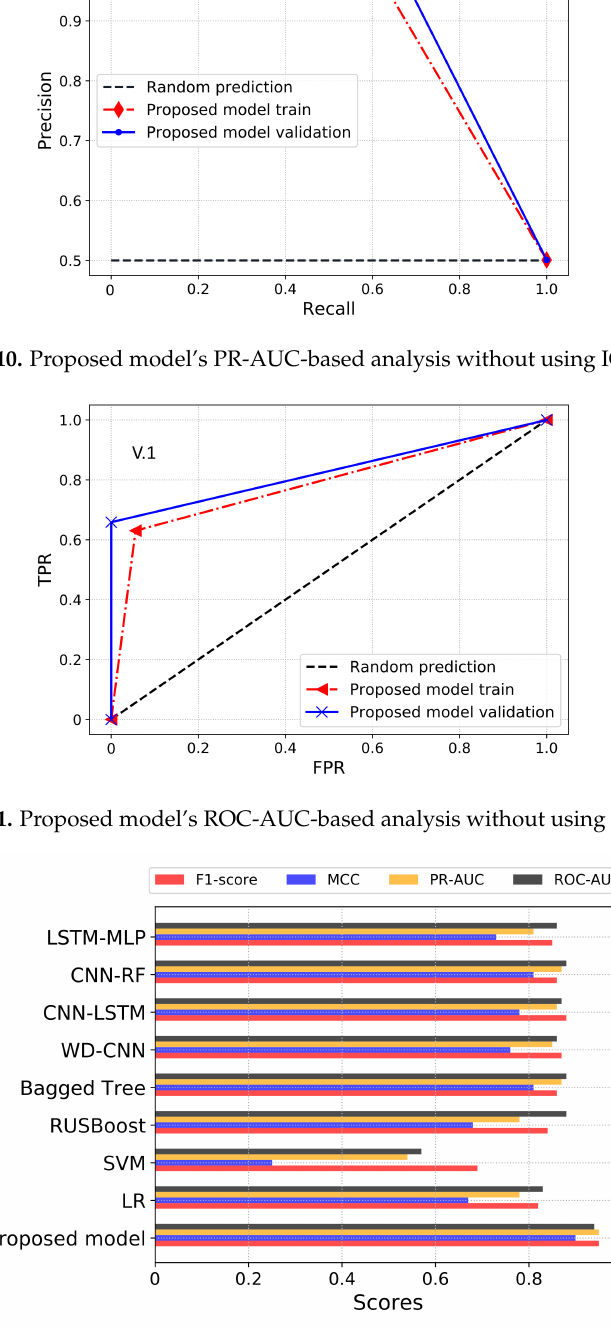
Figure 12. Performance comparison based on F1, MCC, PR-AUC and